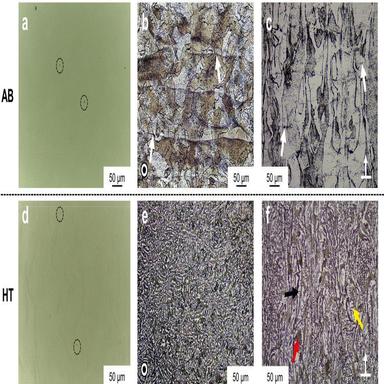
Optical micrographs of LPBF DSS 2205 taken from (a) AB unetched (b) AB build plane (c) AB build direction (d) HT unetched (e) HT build plane and (f) HT build direction.